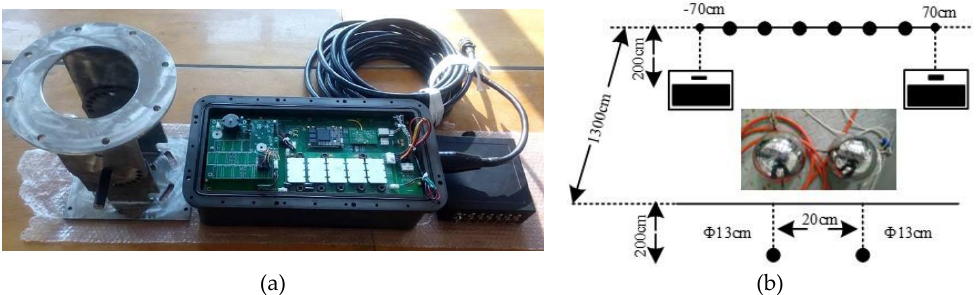
Figure 13. Experimental site and targets to be detected: ( a ) MBSAS principle prototype used in the experiment; ( b ) experimental site and targets. Table 4. Main parameters for MBSAS experiment.